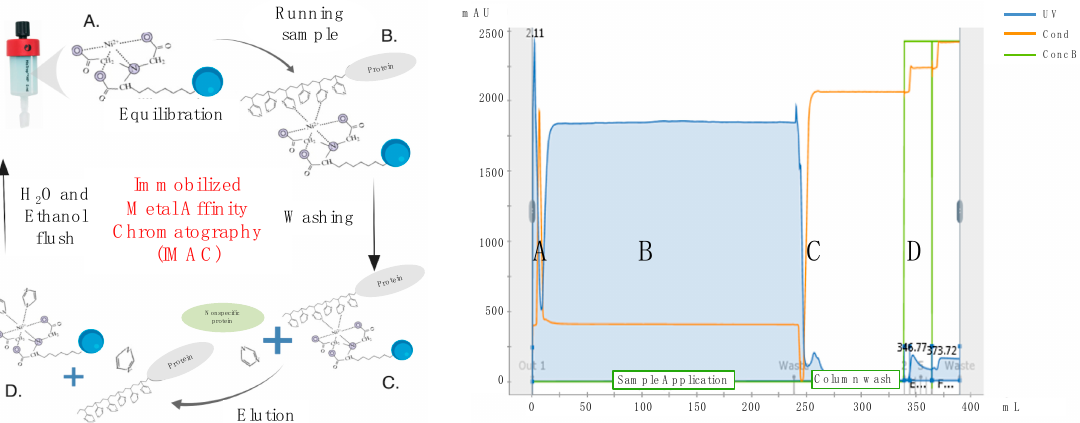
Figure 3. The left panel depicts the free and bound components at each stage of the Immobilized Metal Affinity Chromatography (IMAC) process. The right panel shows the UV readings yielded by the GE ÄKTA pure system with each letter representing the same stage of the purification as in the left panel. Part of the figure was generated with Biorender.